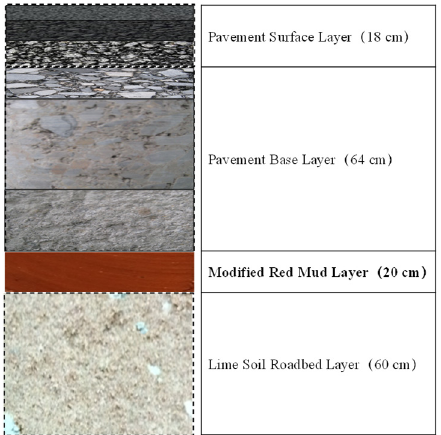
Figure 2. Pavement structure diagram of demonstration road.